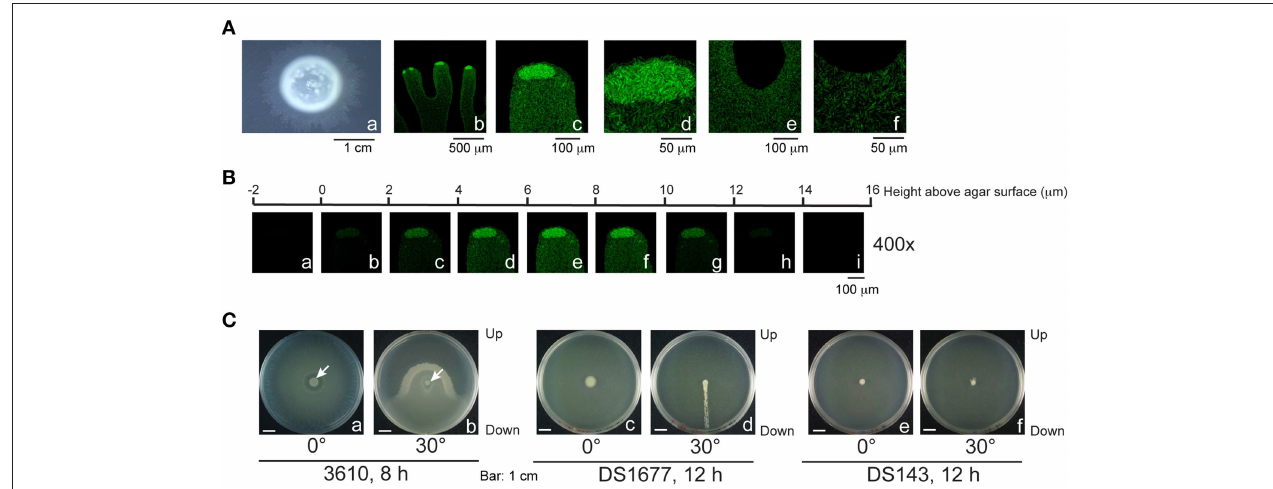
FIGURE 6 | Migration of B. subtilis 3610 in flowing water. (A) (a) B. subtilis 3610 colonies cultured on 25-ml LB-0.7 agar plates for 3h. (b–f) Compressed confocal images from the tendril (b) , tendril tips (c,d) , and the base of two tendrils (e,f) of B. subtilis 3610(pHag-gfp) colonies are shown. (B) Z stack of the edge of a